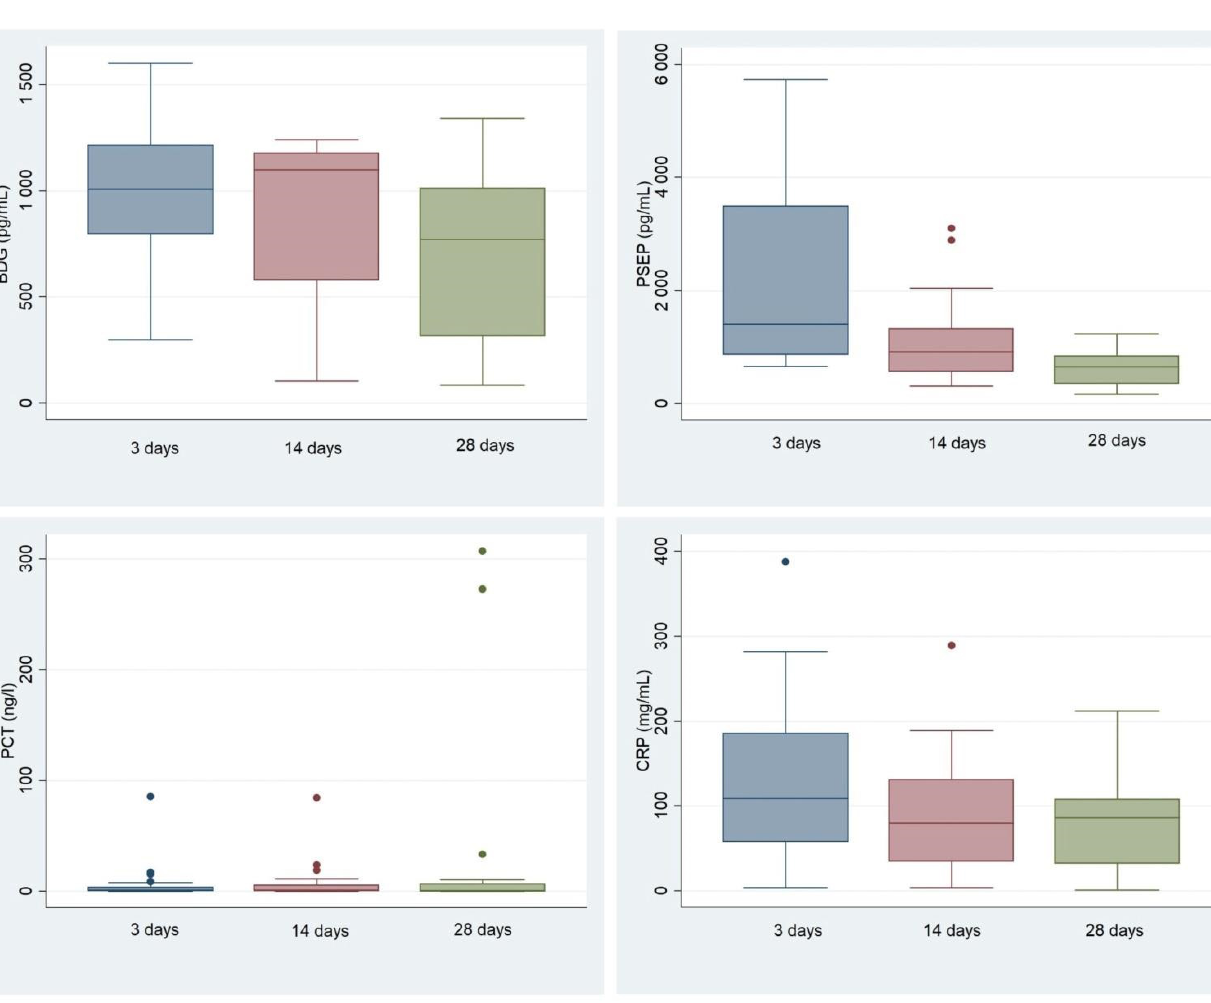
Figure 3. Changes in the Candida sepsis biomarkers PCT, PSEP, CRP, and 1,3- β -D-glucan within 3, 14, and 28 days after echinocandin (ATM)